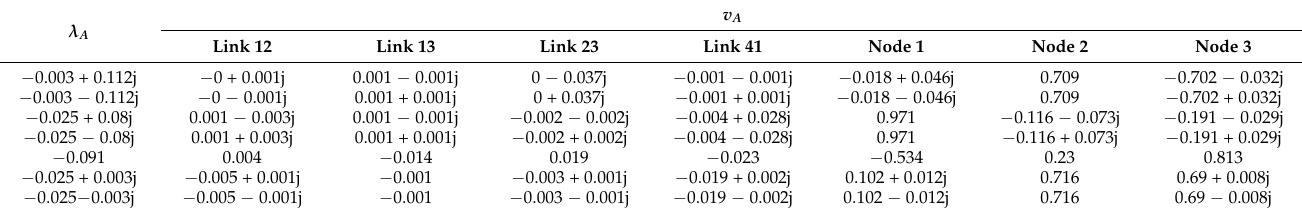
The eigenvalues 𝜆 𝑨 and eigenvectors 𝑣 𝑨 (row-wise) of the state matrix 𝑨 of the triangular network are presented in Table A1. Notice from the eigenvalues that the system is asymptotically stable and will show oscillatory behavior, as expected. The “fastest” characteristic mode is related to the heads in the three nodes (see 5th row of eigenmatrix). Table A1. Eigenvalues and accompanying eigenvectors of system matrix 𝑨.